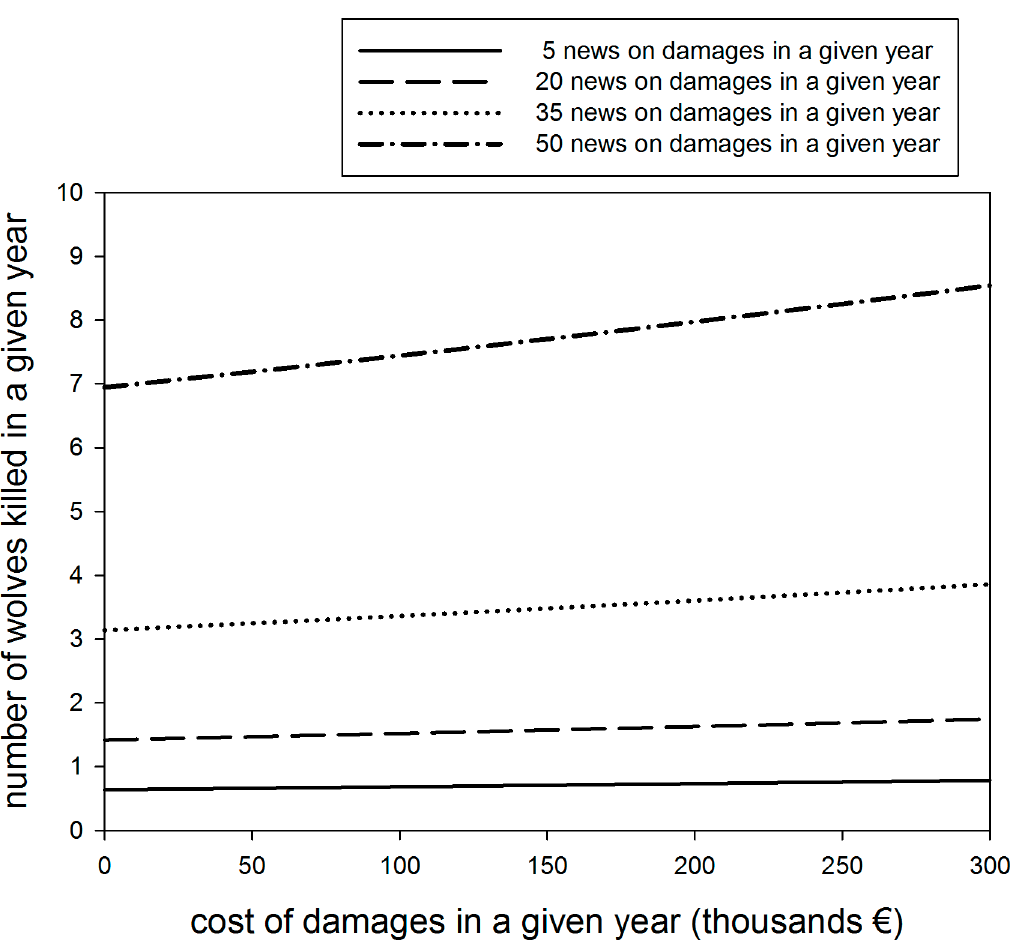
Fig 3. Relationship between wolves culled and compensated damages. The plot is based on the best model relating wolves culled in a given year and the cost of damages compensated in that year, as a function of the number of news on damages published in that year.